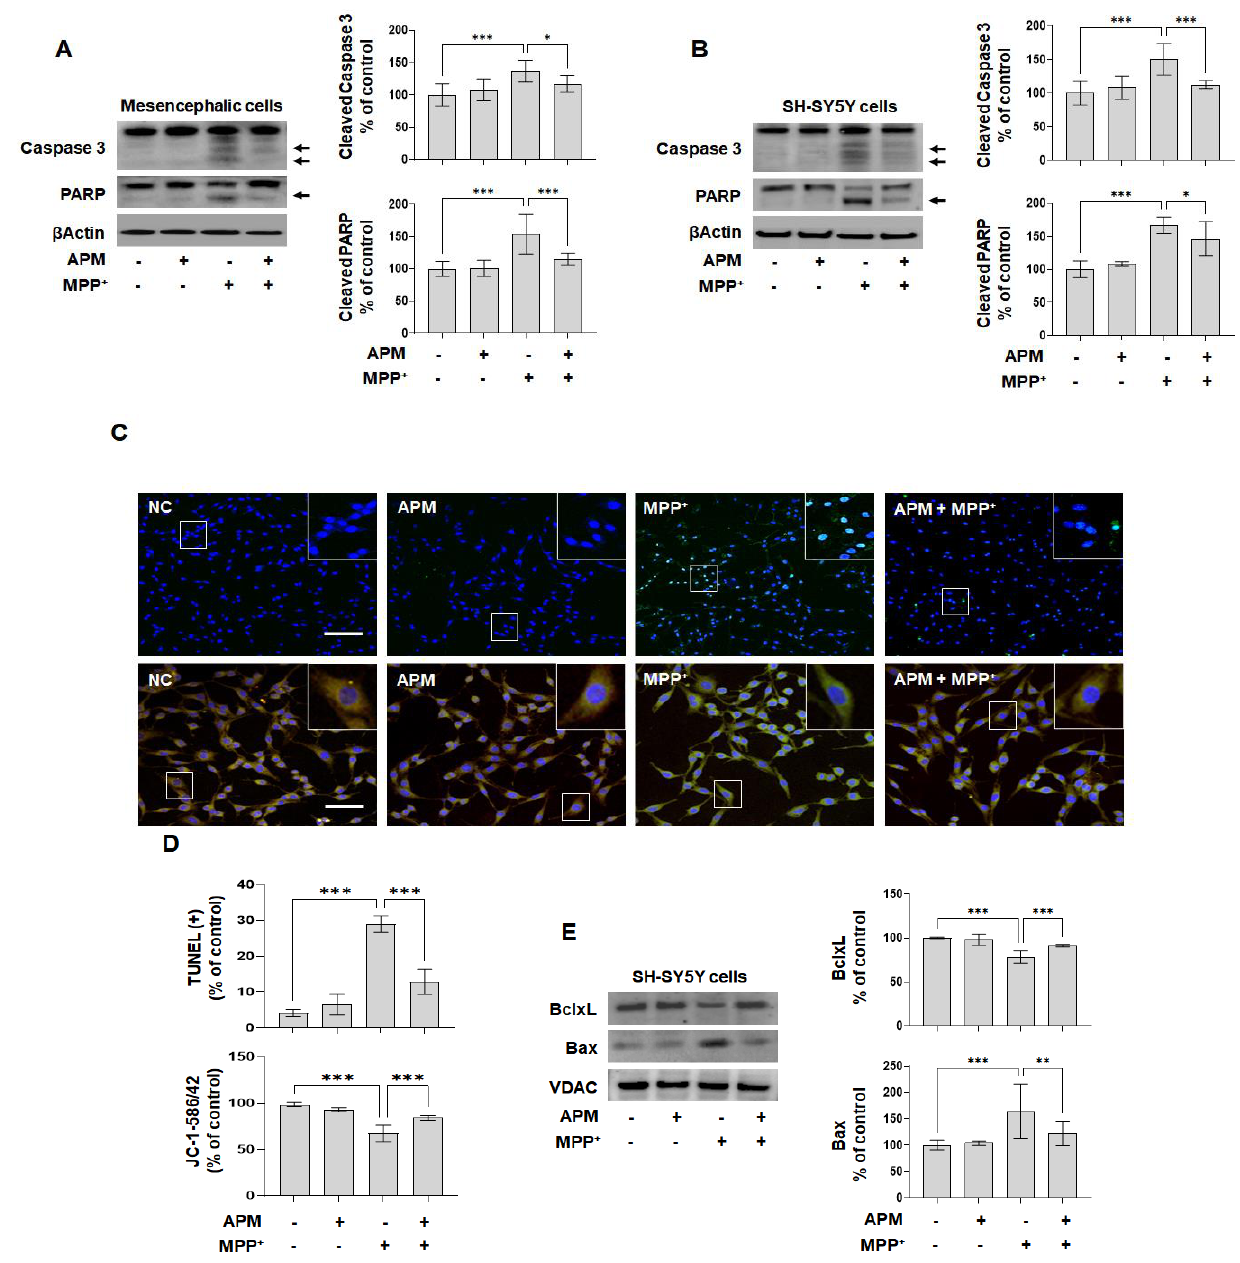
Figure 2. APM protects MPP + -induced mitochondria-dependent neurotoxicity in dopaminergic neuronal cells. SH-SY5Y cells and rat embryo primary mesencephalic neurons were incubated in the presence or absence of APM for 1 h and then treated with MPP + for 12 h or 24 h. Expression of cleaved-Caspase3 and cleaved-PARP in rat embryo primary mesencephalic neurons ( A ) and SH-SY5Y cells ( B ) were detected by immunoblotting. β Actin was used to confirm equal sample loading. Arrows: cleaved form. ( C ) SH-SY5Y cells were evaluated by fluorescence microscopy on the basis of morphological criteria after TUNEL staining (upper, scale bars: 100 μ m) and JC-1 mitochondrial staining (lower, scale bars: 50 μ m) and immunofluorescence positive cells were quantified by den- sitometric analysis ( D ). Nuclei were stained with DAPI. APM regulates mitochondrial apoptotic proteins ( E ). VDAC was used as mitochondrial loading control. Immunoblotting was quantified by densitometric analysis. The data are representative of three independent experiments and quanti- fied as mean values ± SEM. Tukey’s multiple comparison test, * p < 0.05, ** p < 0.01, *** p < 0.001 compared to normal control.